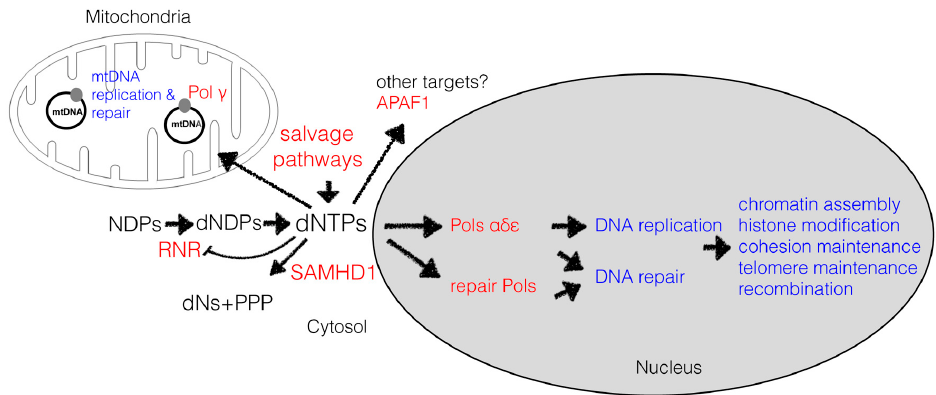
Figure 1. Overview of dNTP levels and impact on cellular processes. dNTP levels depend on a balance between synthesis, consumption, and degradation. Consumption of dNTPs in DNA synthesis influences a wide range of activities due to the relationship between DNA replication and other chromosomal processes. As well as affecting DNA polymerase function, dNTPs may target other proteins such as APAF1. (APAF1: Apoptotic protease activating factor 1; dNs: deoxyribonucleosides; PPP: triphosphate; RNR: ribonucleotide reductase).